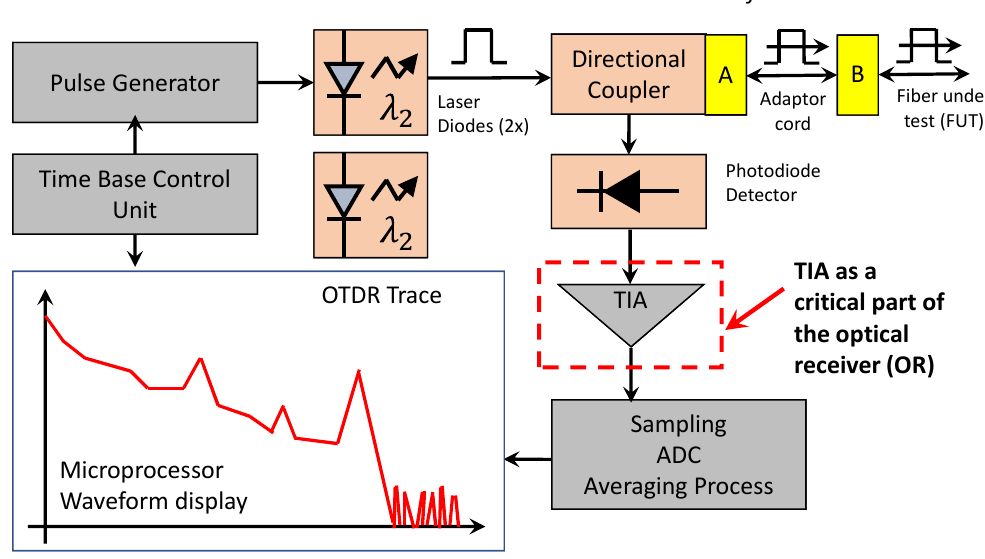
Figure 2. Block functions of a typical OTDR